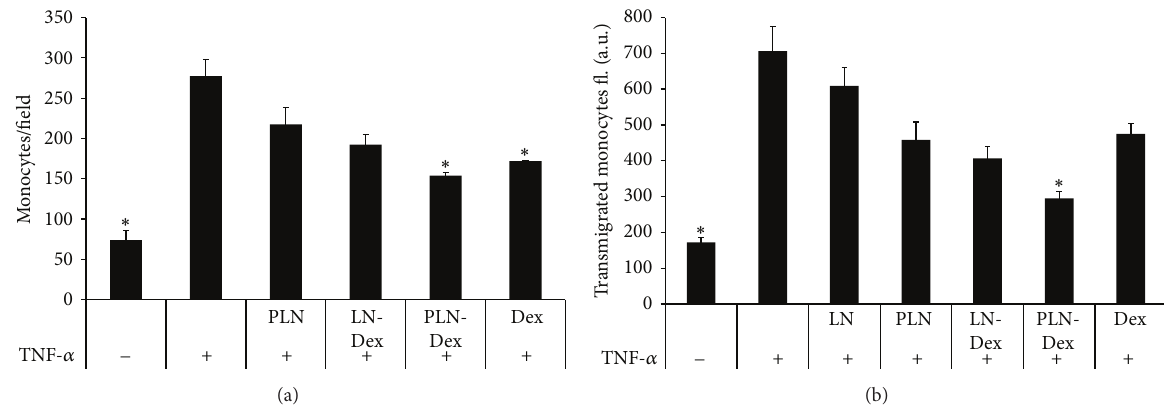
Figure 3: Adhesion (a) and transmigration (b) of monocytes (THP-1 line) to/through TNF- 𝛼 activated EC in the presence of dexamethasone eitherfree(Dex)orencapsulatedinnontargeted(LN-Dex)orP-selectintargeted(PLN-Dex)lipidnanoemulsions.Emptynontargeted(LN)or P-selectin targeted lipid nanoemulsions (PLN) were used as controls. The data are expressed as mean ± SD of three independent experiments. ∗ 𝑝 < 0.05 significantly different from TNF- 𝛼 -activated